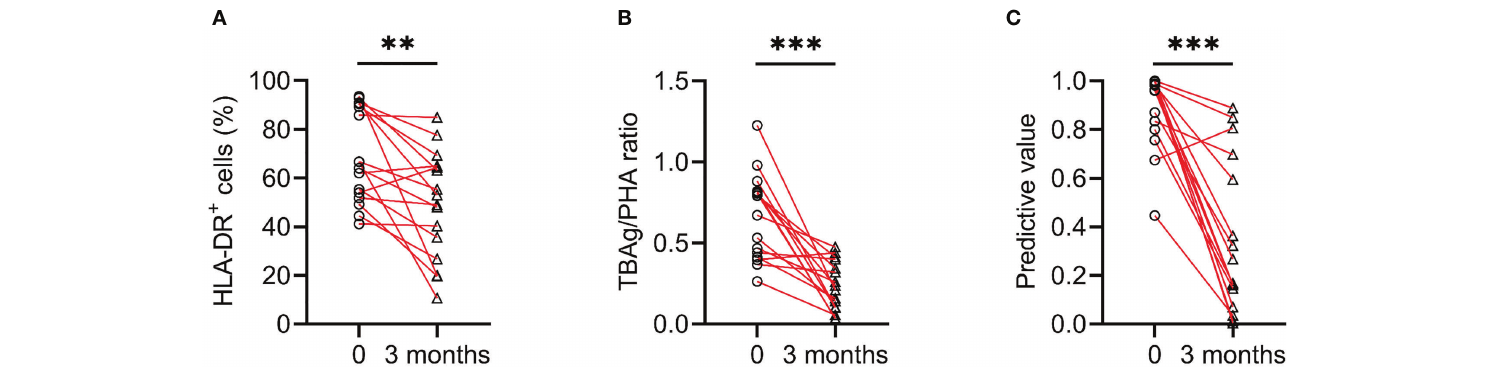
FIGURE 3 | The change of various indicators after anti-TB treatment. (A) Line graphs showing the expression of HLA-DR on IFN- g + TNF- a + cells in ATB patients before and after 3 months of anti-TB treatment. ** P < 0.01 (Wilcoxon test). (B) Line graphs showing the levels of TBAg/PHA ratio in ATB patients before and after 3 months of anti-TB treatment. *** P < 0.001 (Wilcoxon test). (C) Line graphs showing the predictive values of diagnostic model in ATB patients before and after 3 months of anti-TB treatment. *** P < 0.001 (Wilcoxon test). TBAg, tuberculosis antigens; PHA, phytohemagglutinin.